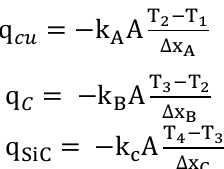
Changes of heat flux at different thicknesses of Silicon Carbide ∆𝑥 with fix thickness of solid carbon ( ∆𝑥 𝒄